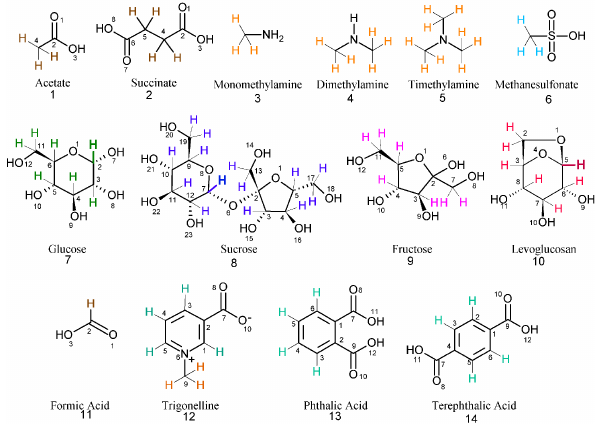
Figure 3. Structures of compounds assigned from the NMR spectra of fractionated aerosols. The protons responsible for the NMR sig- nals are colored as follows: brown (bound to carbon alpha of the car- boxylic acid group), orange (methyl groups bound to amines), light blue (bound to carbon alpha of the sulfonic acid group), green (glu- cose), blue (sucrose), purple (fructose), red (levoglucosan), light green (aromatic hydrogen). The H in bold indicates the signals in the 5.1–5.7ppm range (see Fig.